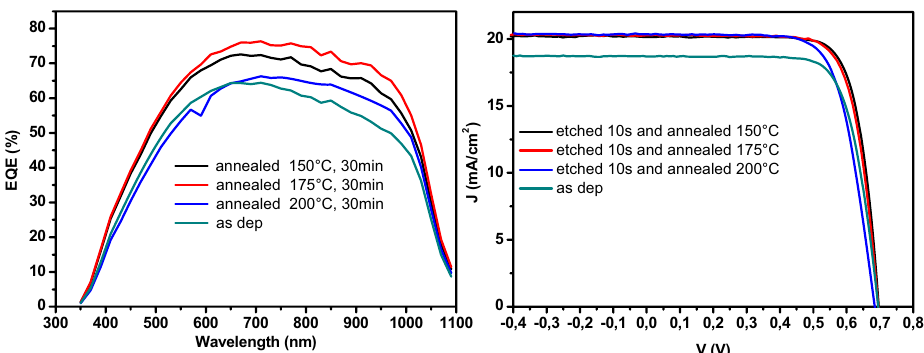
Fig. 4. EQE and I - V curves of ZnO:Al HJ for different annealing temperture. ZnO:Al thickness: 1 µ m, annealing 30